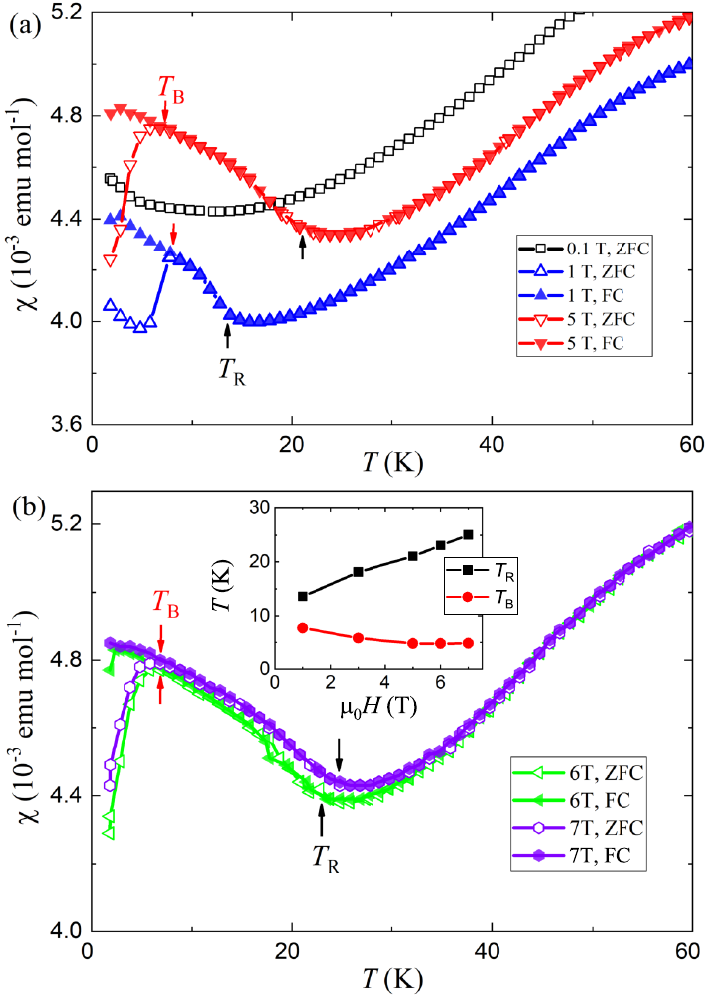
Figure 4. Temperature dependence of magnetic susceptibility for Sr 2 Cr 2 AsO 3 at varied magnetic fields of 0.1, 1, 5 ( a ), 6, and 7 T ( b ) in the field-cooling (FC) and zero-field-cooling (ZFC) measurement modes. The inset of ( b ) shows the changes of T R and T B with the magnetic